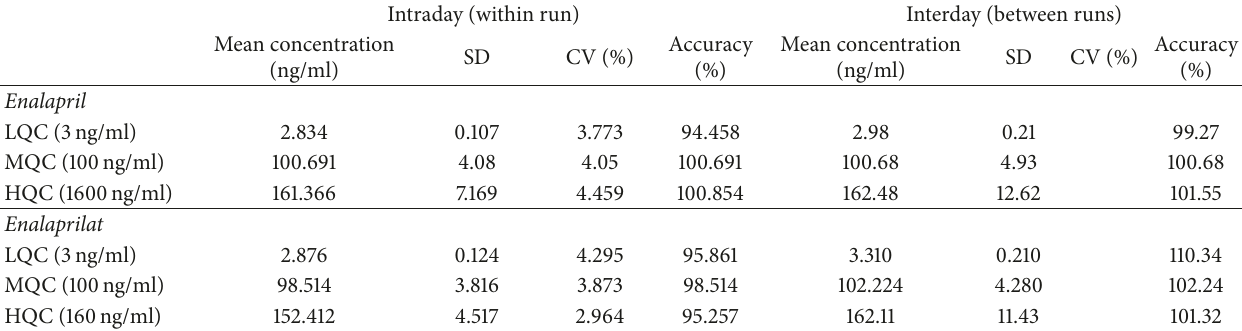
Table 1: Intra- and interday precision and accuracy data for enalapril and enalaprilat in human plasma ( 𝑛 = 6 ). Intraday (within run) Interday (between runs) Mean concentration Accuracy Mean concentration SD CV (%) (ng/ml) (%) (ng/ml)